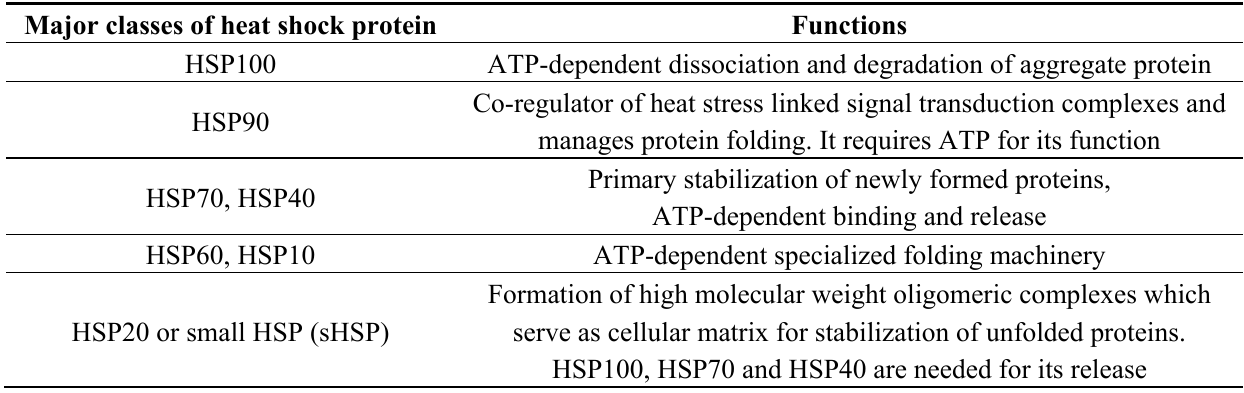
Table 3. An outline of basic function of major classes of heat shock proteins in plant system for heat stress